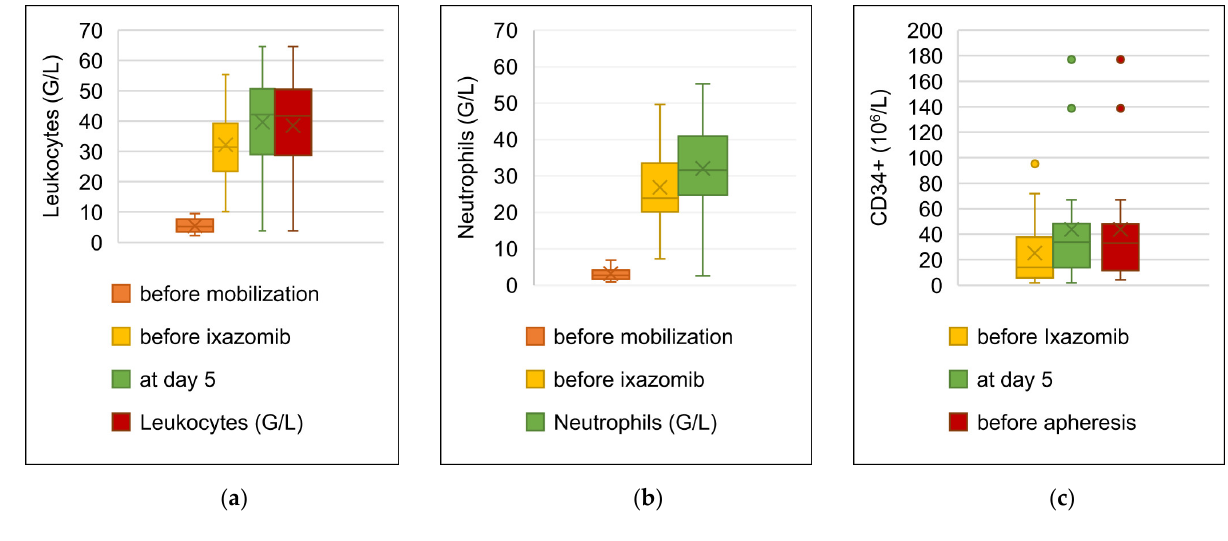
Figure 2. Box plot illustrating modifications in number of circulating ( a ) leukocytes, ( b ) neutrophils and ( c ) CD34+ cells during stem cell mobilization with ixazomib and G-CSF. In one patient, we additionally performed serial monitoring of circulating CD34+ cells and leukocytes at 3 h, 8 h, 12 h, 16 h and 19 h after ixazomib intake (Figure 3). The fastest increase of CD34+ cells was observed between 3 and 8 h after ixazomib administration, and peak values were detected at 19 h.